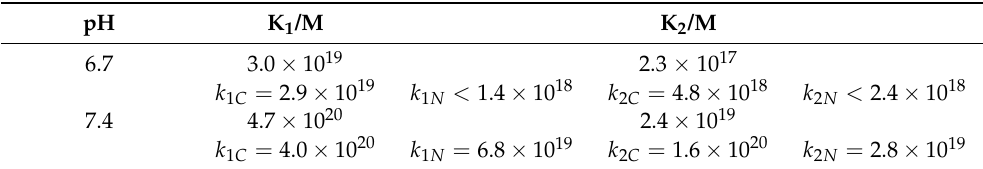
Figure 3. Iron-binding site of the N-lobe in human serum holotransferrin. Iron is coordinated by two tyrosine, histidine, aspartate, and carbonate. The iron in the C-lobe is also coordinated by the same amino acids. The structure was generated using UCSF Chimera [32]. PDB: 3V83. Table 2. Effective stability constants, macroscopic (K 1 , K 2 ) and microscopic (k 1 C , k 1 N , k 2 C , k 2 N ), for iron binding to transferrin (modified from